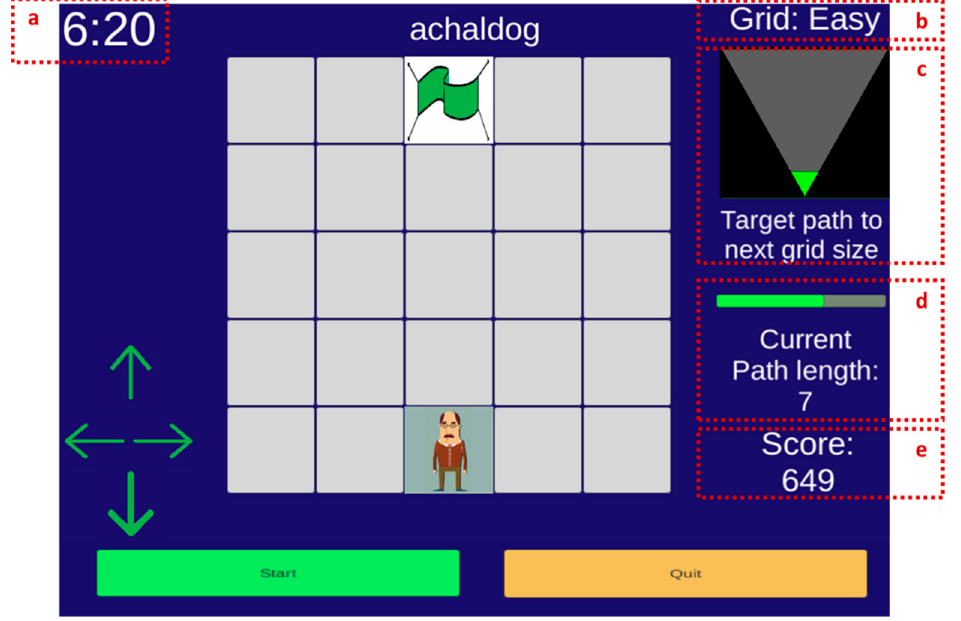
Figure 1. Sample of the game’s main screen.